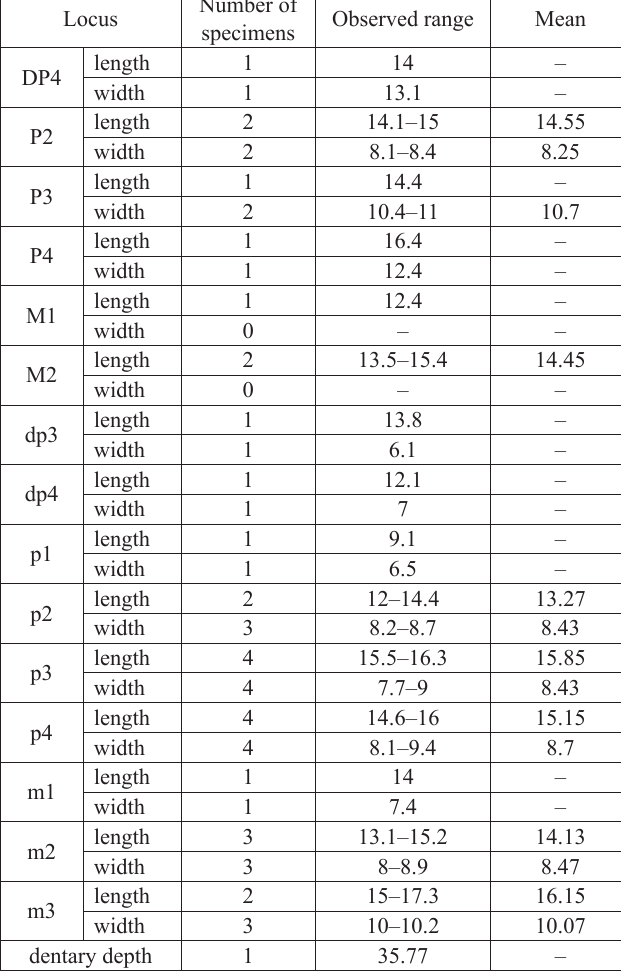
sp. nov. from Egerkingen γ (MP13?). Dentary depth measured below the m1. Body mass = 28.65 kg (estimated after Morlo